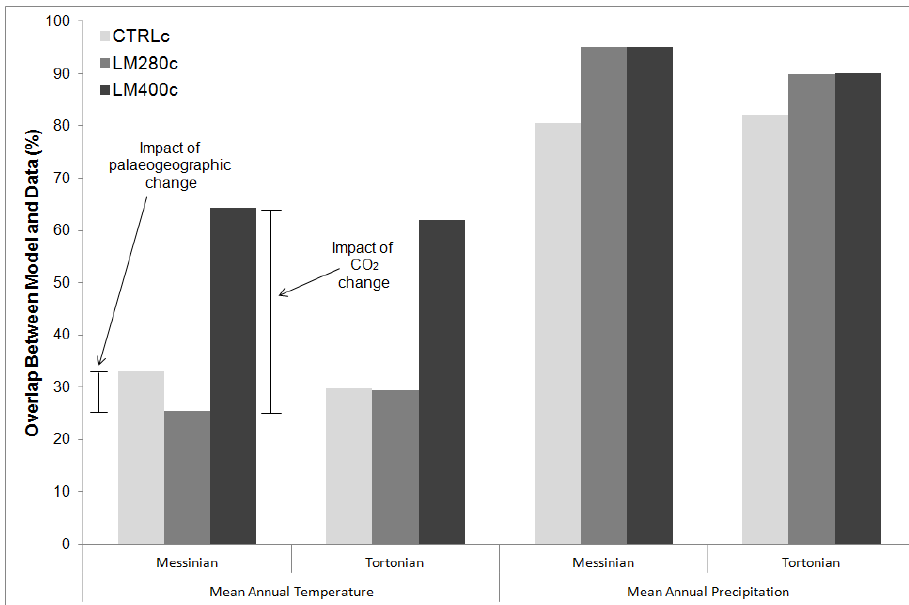
Fig. 17. Model–data comparison summary for MAT and MAP. Shown are the percentages of the total number of datapoints that overlap with the model results.